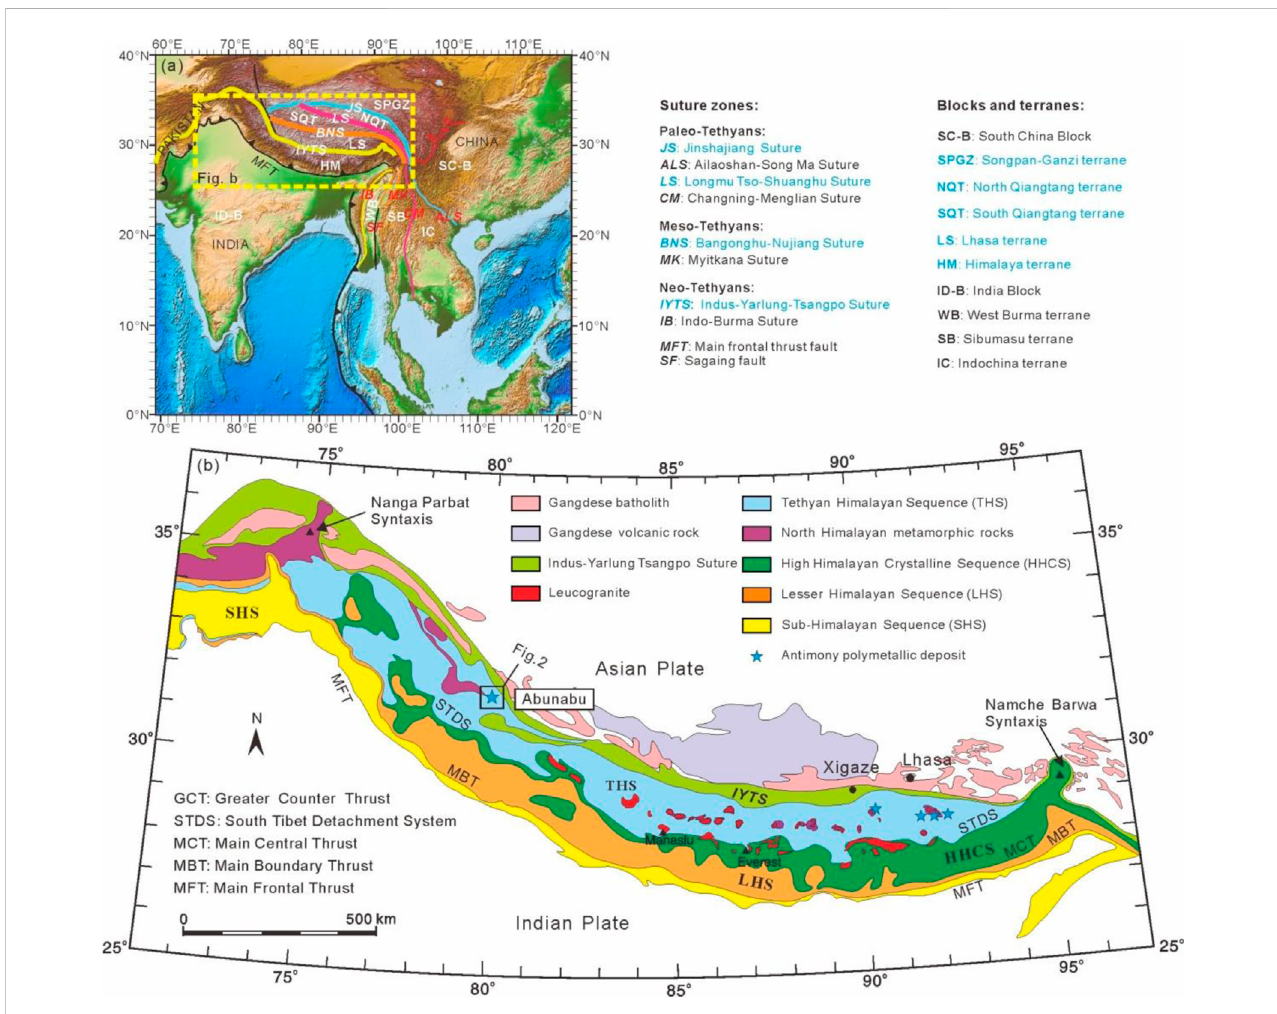
FIGURE 1 Tectonic map of the Himalaya – Tibetan Plateau region: (A) geotectonic sketch of southeastern Asia (Yin and Harrison, 2000; Cao et al., 2018); (B) simpli fi ed geological map of Himalaya, showing the major antimony polymetallic deposit (modi fi ed after Cao et al., 2018; Guillot et al., 2008; Zhang et al., 2019; Dai et al.,